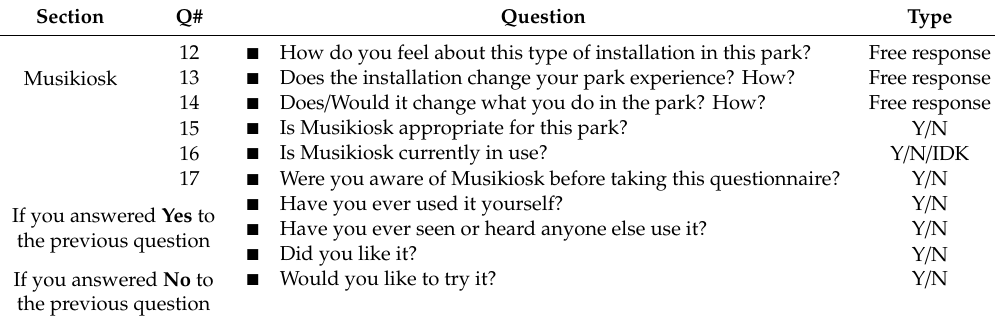
Table A3. Questionnaire Q3, Musikiosk non-users, presented in addition to Q1